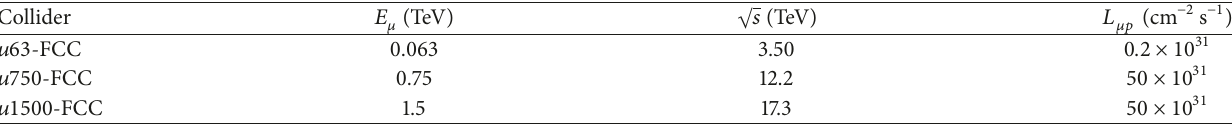
Table 1: Main parameters of the FCC-based 𝜇𝑝